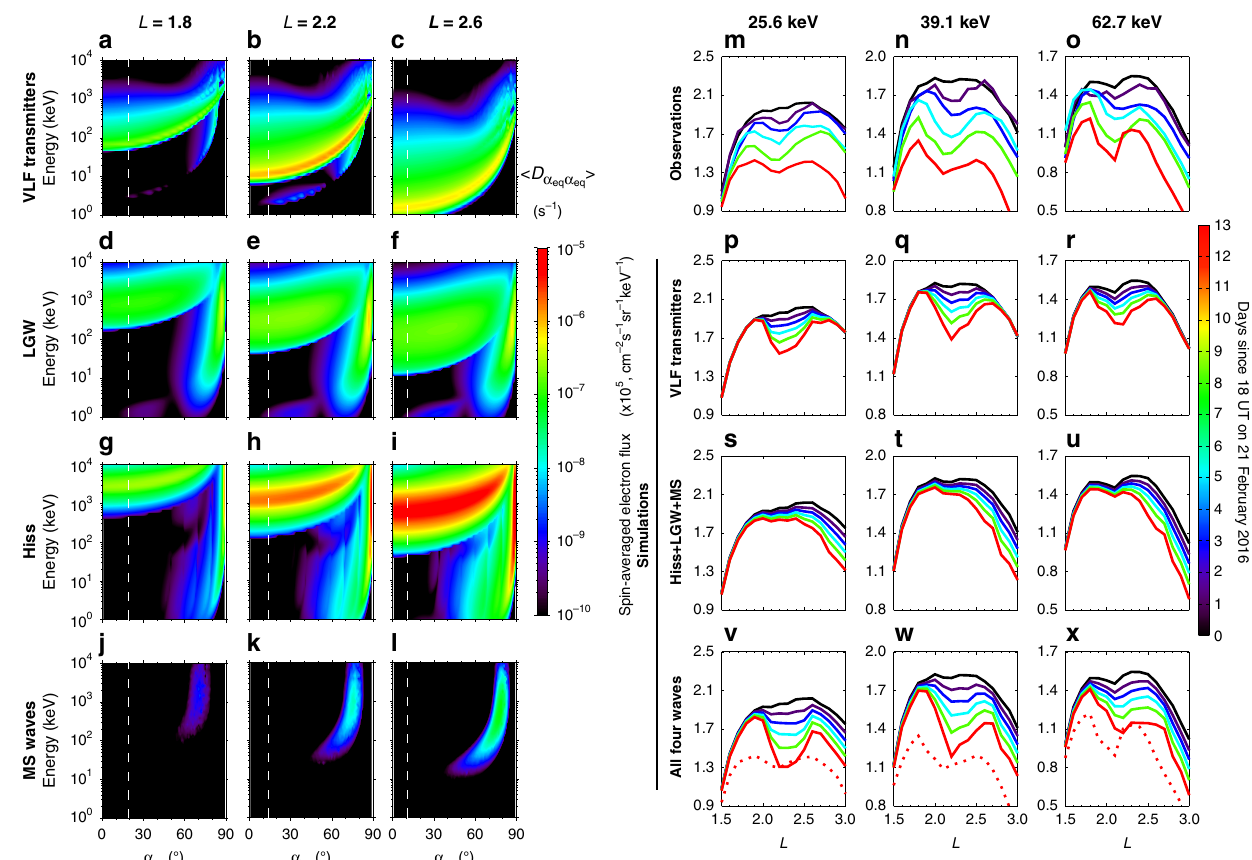
Fig. 3 Computation of electron diffusion coef fi cients and comparison of the simulation results to observations. a – c Drift- and bounce-averaged pitch- (cid:1)(cid:3) (cid:4)(cid:5) D angle diffusion coef fi cients as a function of equatorial pitch-angle ( α eq ) and electron energy at L = 1.8, 2.2, and 2.6 for VLF transmitter waves, α eq α eq d – f , lightning-generated whistlers (LGWs), g – i plasmaspheric hiss, and j – l magnetosonic (MS) waves. The vertical white dashed lines in ( a – l ) represent the equatorial bounce loss cone at the given L -shell. m – o Spatiotemporal evolution of the spin-averaged electron fl ux pro fi le observed by RBSPICE averaged every 6 h during the period from 21 February to 5 March 2016 for three speci fi c kinetic energies of 25.6, 39.1, and 62.7 keV, corresponding to Fig. 1c – e. Two-dimensional Fokker-Planck simulation results of the temporal evolution of spin-averaged electron fl uxes due to three different sets of waves: p – r VLF transmitter waves only; s – u , combination of plasmaspheric hiss, lightning-generated whistlers (LGWs) and magnetosonic (MS) waves; v – x all four-wave types. The red dotted lines in ( v – x ) represent the observed electron fl uxes, which are the same as the results of red solid lines in ( m – o